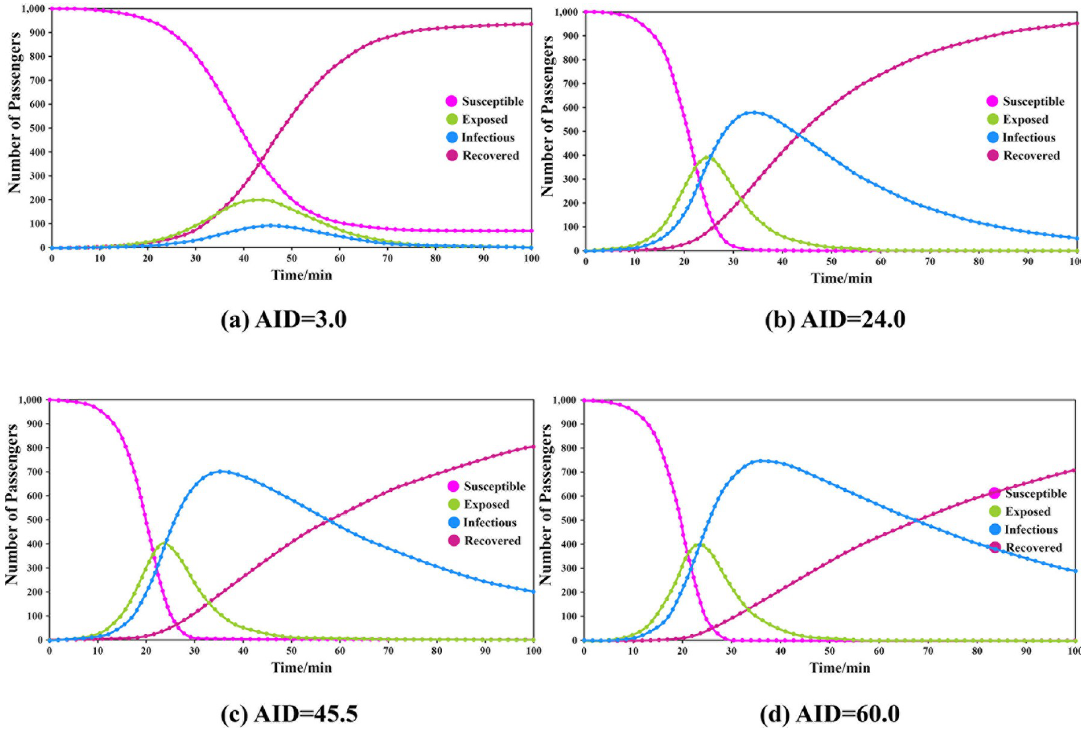
Fig 3. Results of different groups under different durations of